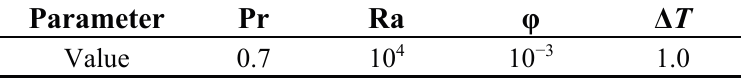
Table 3. The entropy generation parameters as in